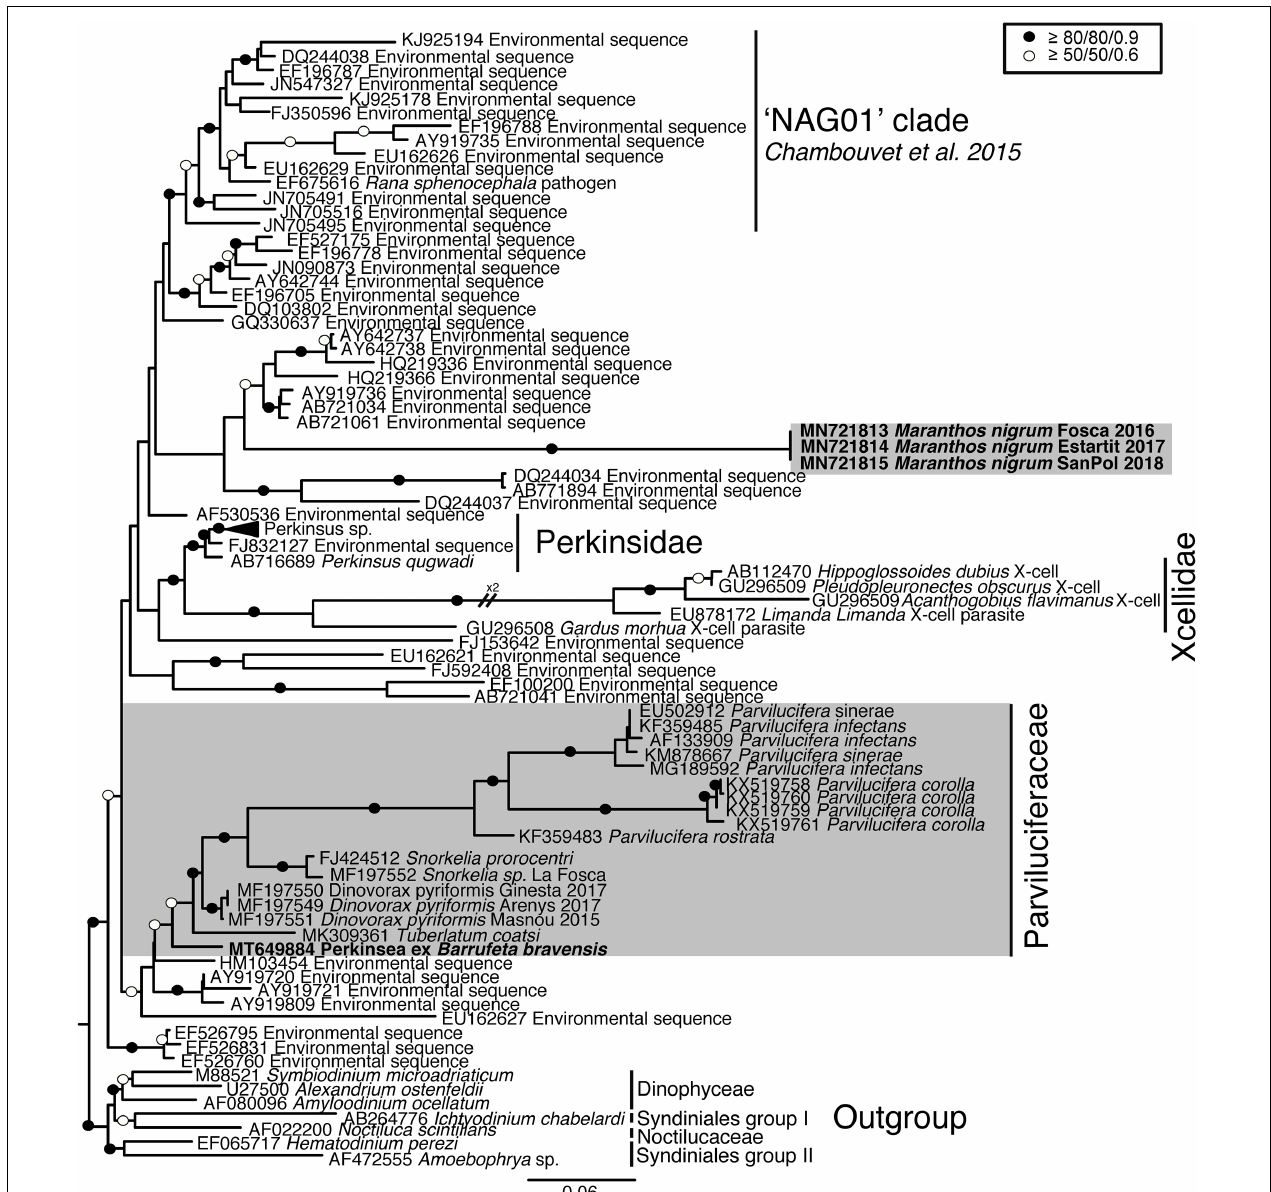
FIGURE 1 | Maximum likelihood phylogenetic tree inferred in IQ-TREE with GTR + F + R9 model from the SSU rRNA gene sequences of Perkinsea. Sequences of Dinophyceae and Syndiniales served as the outgroup. Value at branches correspond to ultrafast bootstrap (10,000 replicates, GTR + F + R9 model), non-parametric bootstrap (1000 replicates, CATGTR model) and Bayesian posterior probabilities (2,000,000 generations, GTR + G model). Support values are summarized by black circles when all are ≥ 80%/80%/0.9, and a white circle when topology support is weaker but all values are ≥ 50%/50%/0.6. Sequences obtained in this study are indicated in bold; the shaded area indicates parasitoids of